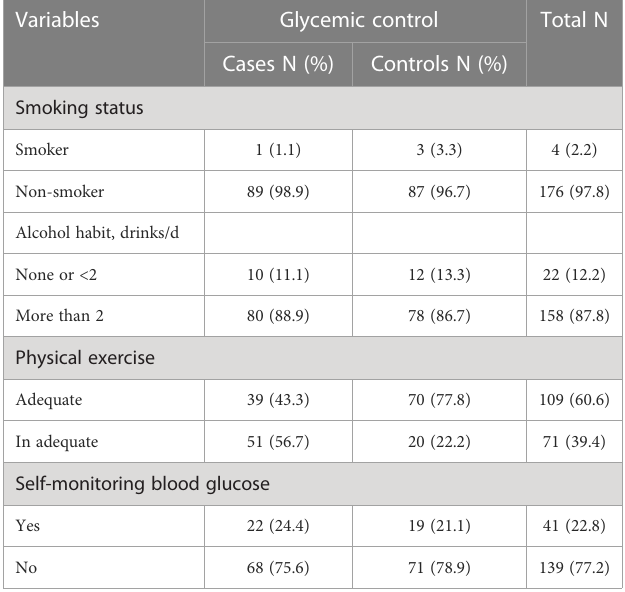
TABLE 2 Behavioral characteristics and diabetes self-care activities in type 2 diabetes mellitus patients at DM clinic of UoGCSH, Northwest Ethiopia, 2020